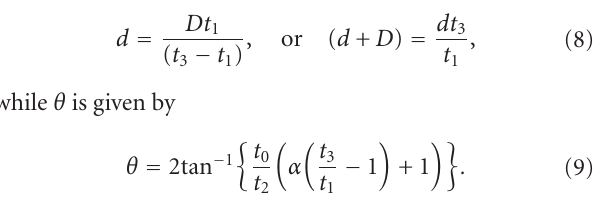
The solution to (4)–(7) gives a constant ratio for D to d